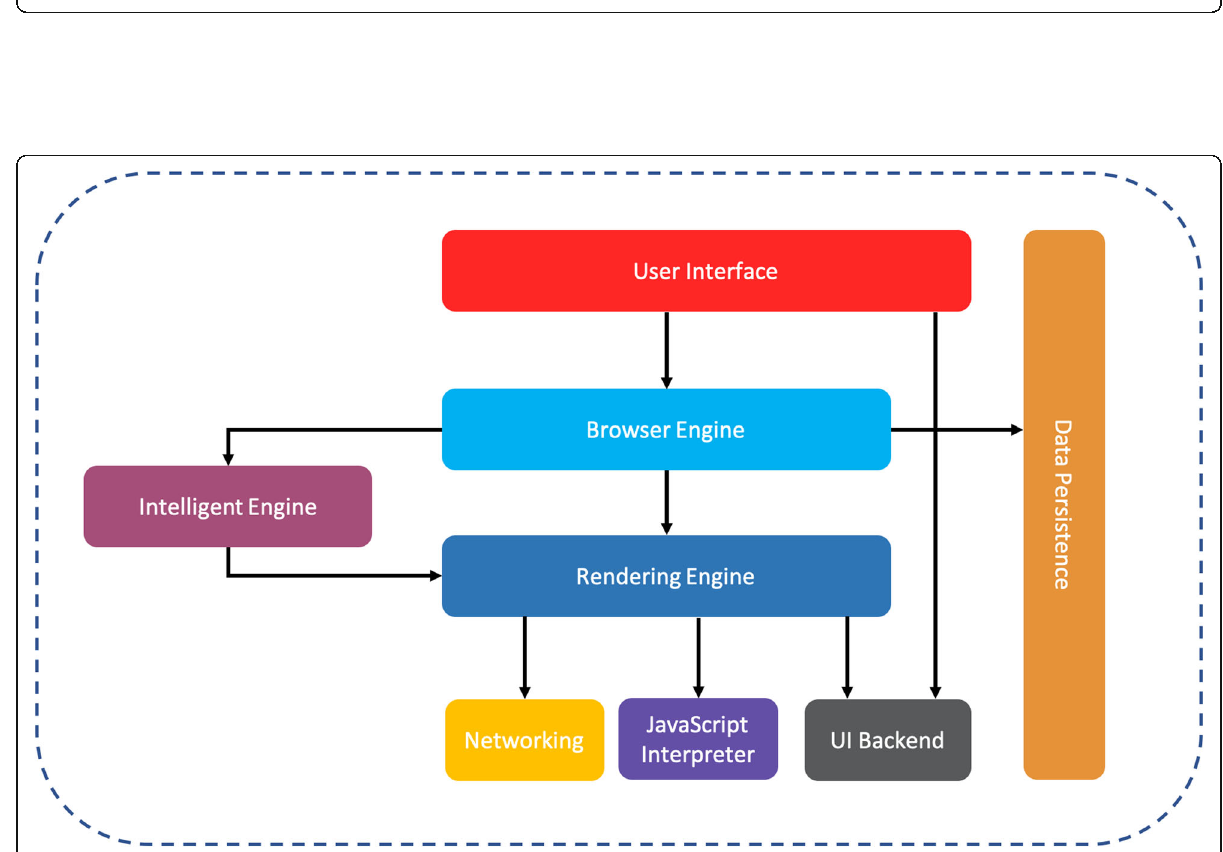
Fig. 2 Most-Targeted Industry Sectors 2019 (APWG trends report q1 2019 n.d.; APWG trends report q2 2019 n.d.; APWG trends report q3 2019 PRODUCTION n.d.; APWG trends report q4 2019 n.d.)